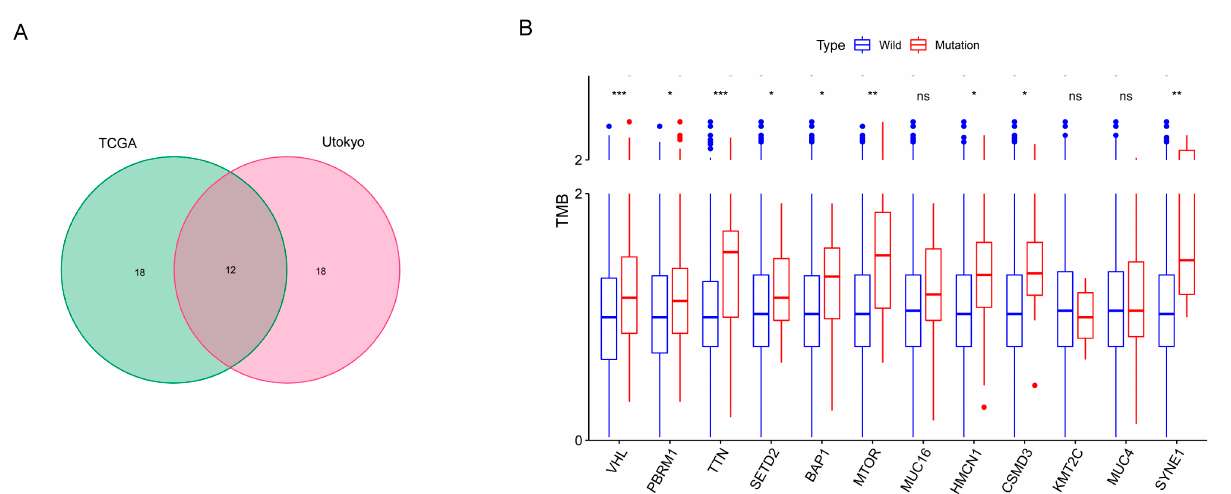
Figure 3. TMB-related gene mutations. ( A ) Venn diagram figures out 12 frequently mutated genes included in both two cohorts. ( B ) Boxplot reveals the correlation of gene mutation and TMB. *: p < 0.05; **: p < 0.01; ***: p < 0.001; ns: p > 0.05.